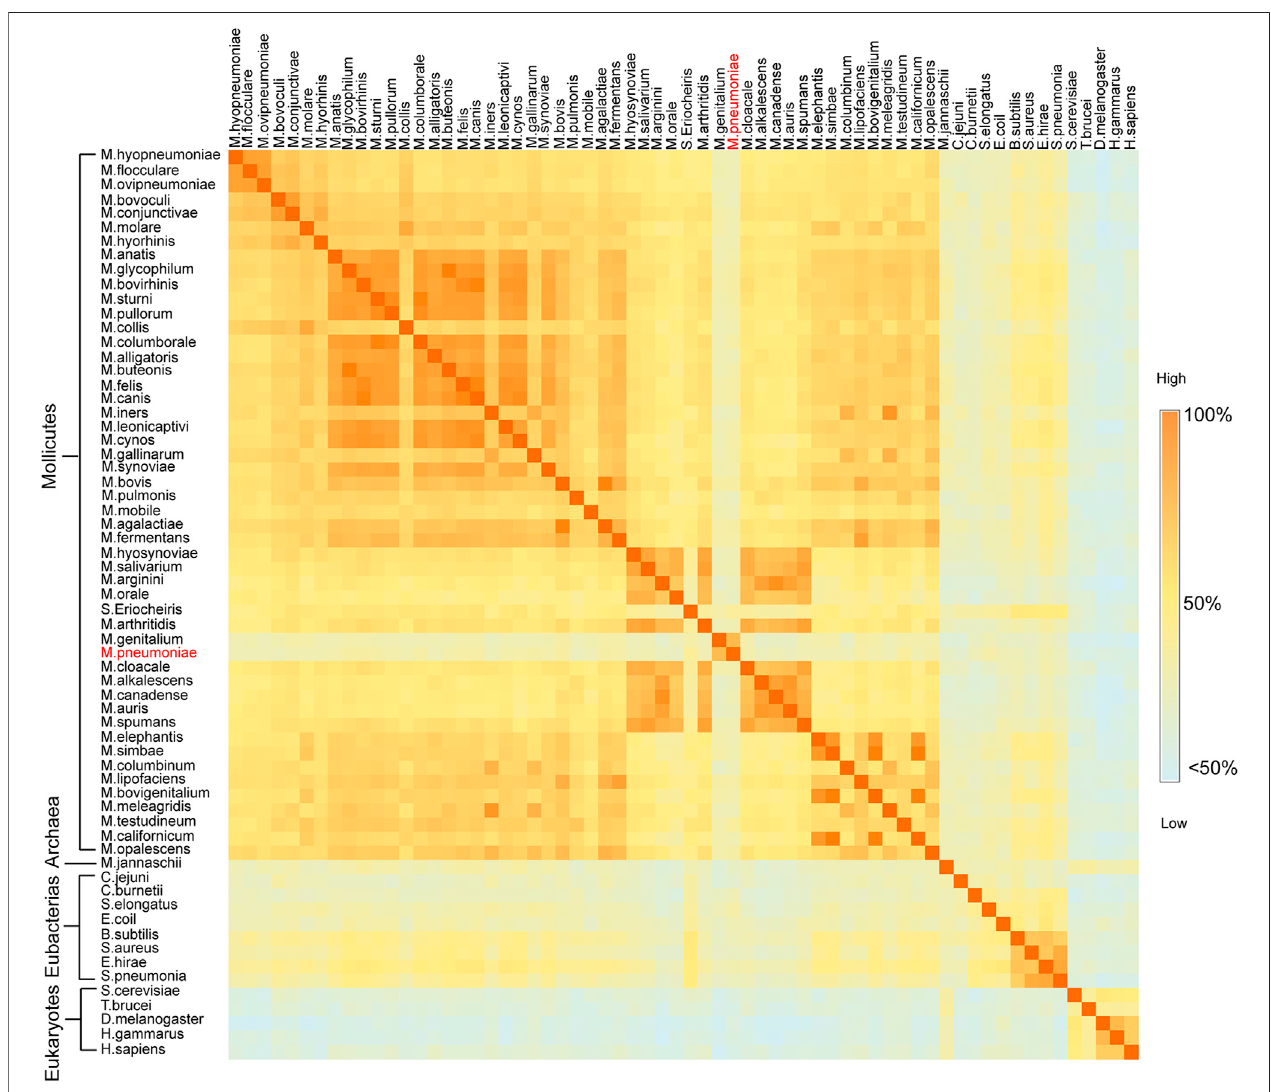
FIGURE1| Sequencesimilaritymatrixbetweentwoenolasesfromdifferentspecies.Heatmapofthesequenceidentitymatrixbetweentwoenolasesfromdifferent species. The species names for every row and column are noted. The block shows the sequence identity between the enolases of the two intersecting species. The degree of sequence similarity is colored from dark orange to light